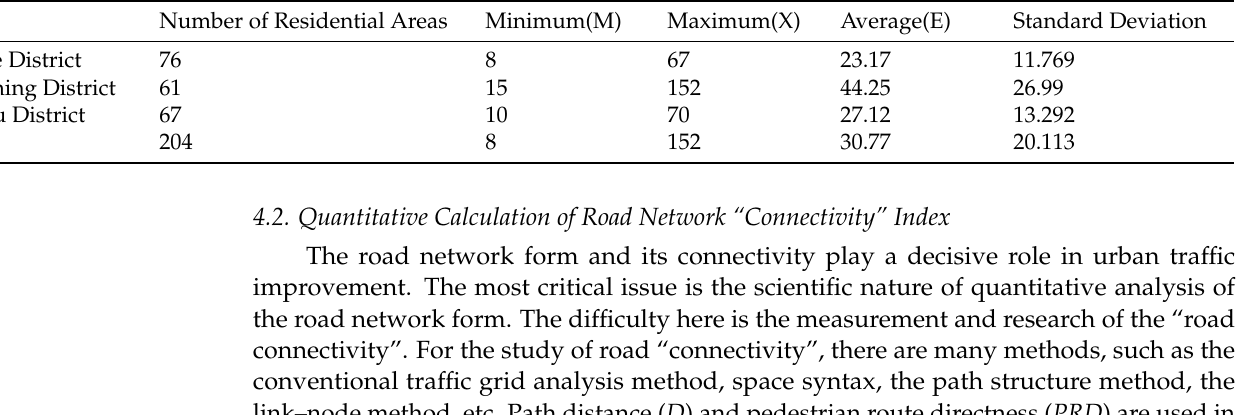
Table 6. The number of nodes of the residential areas in Jiangning, Jianye, and Pukou District.